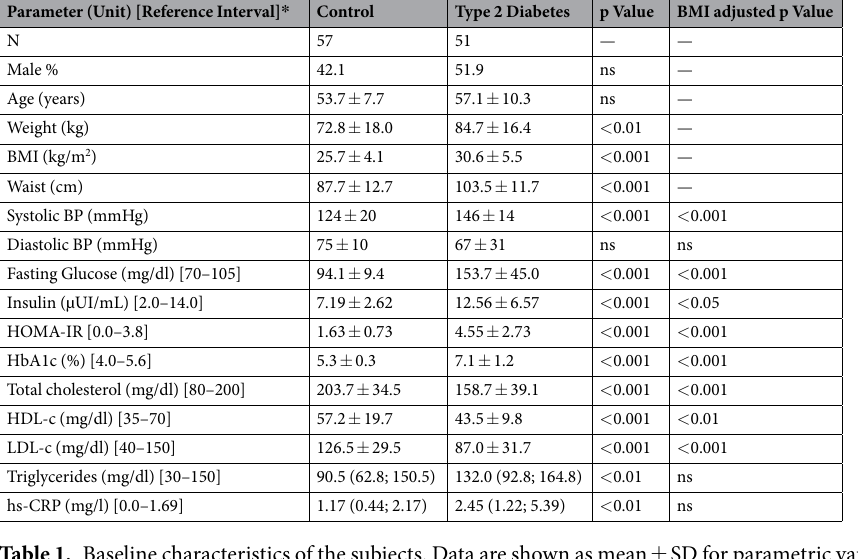
Table 1. Baseline characteristics of the subjects. Data are shown as mean ± SD for parametric variables and were compared by a Student’s t test, or as median (25 th and 75 th percentiles) for non-parametric variables and were compared by a Mann–Whitney U test. A univariate general linear model was used to adjust changes by BMI. To compare proportions among groups, Chi-Square test was used. * Reference intervals according to the service of clinical analysis of our hospital were taken into account for the interpretation of clinical laboratory Leukocyte-endothelium interactions.